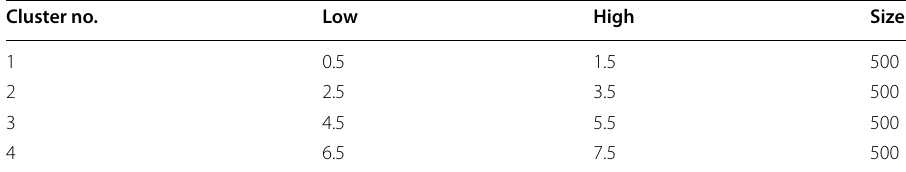
Table 1 The parameters list of uniformly distributed dataset Cluster no.